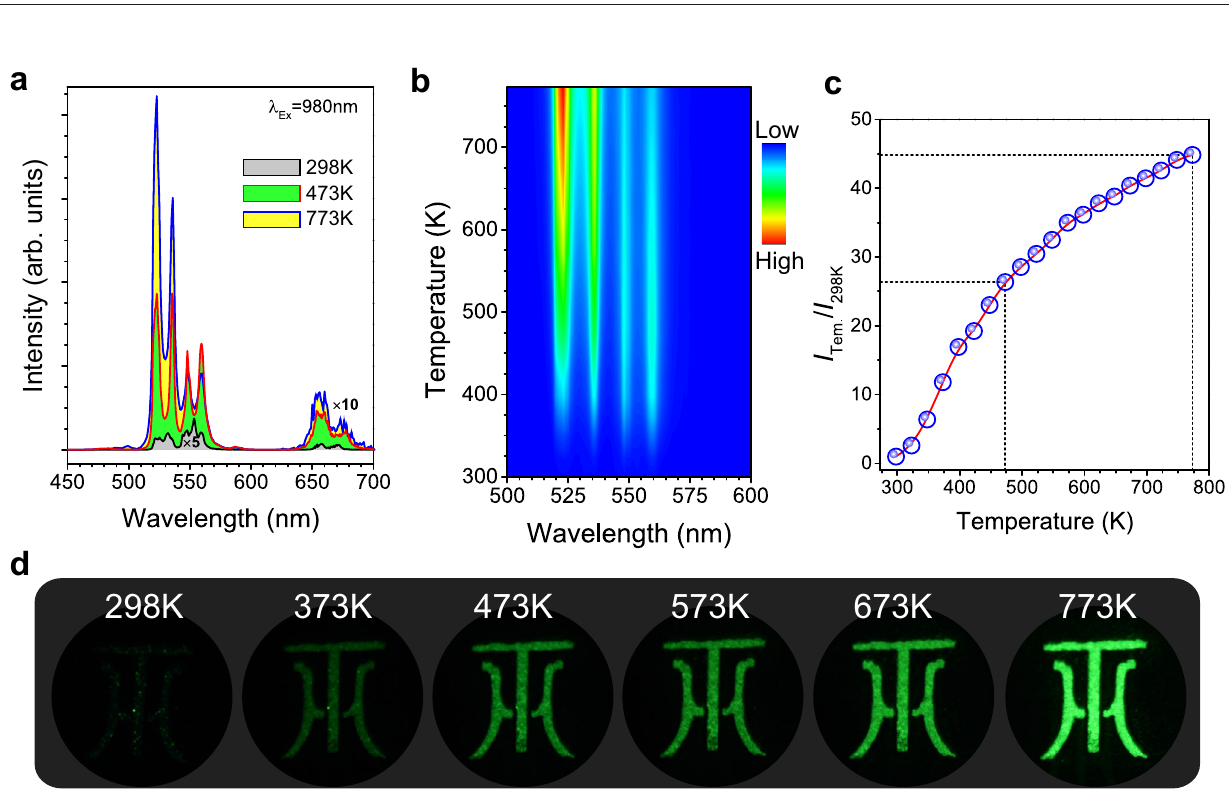
Fig. 2 Negative-thermal expansion in Sc 2 (MoO 4 ) 3 :20%Yb/1%Er. a , b Two-dimensional topographical mapping of temperature-dependent in situ synchrotron X-ray diffraction patterns of (020), (200), and (002) peaks with the temperature from 298 K to 673 K. c Temperature-dependent unit cell parameters a , b , and c of the Sc 2 (MoO 4 ) 3 :20%Yb/1%Er phosphors derived from in situ SXRD patterns. d Temperature-dependent proximate distances of RE-RE (RE = Sc/Yb/Er) along different axes derived from the unit cell structure. e Rigid unit mode model for Sc 2 Mo 3 O 12 :20%Yb 3 + /1%Er 3 + extracted from the unit cell structure. f Temperature-dependent ratio δ D of RE-Mo distances marked in the model ( δ D ¼ D T (cid:2) D 420 D distances of the given temperature and 420 K, respectively). g Temperature-dependent ratio δ θ of RE - Mo-RE angles marked in the model ´ 100 % , θ θ ( δθ ¼ θ T (cid:2) θ 420 θ T and 420 stand for RE-Mo-RE angles of the given temperature and 420 K, respectively). h Temperature-dependent in situ Raman 420 spectra with the temperature from 298 to 773 K. * stands for the characteristic Raman peak of the hydrated orthorhombic structure. i and j . Raman shifts at different temperatures. ν 1 , ν 2 , ν 3 , and ν 4 stand for symmetric stretching, symmetric bending, asymmetric stretching, and asymmetric bending mode of MoO 4 tetrahedra, respectively.